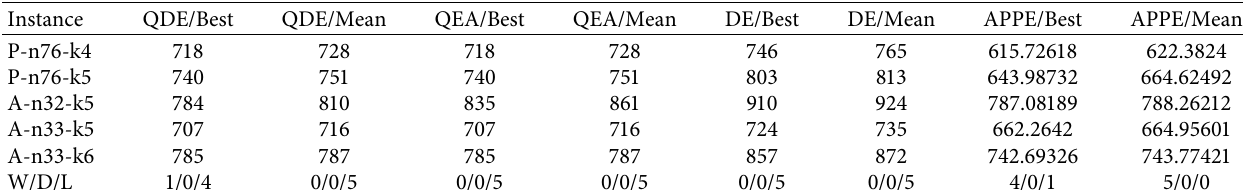
Table 18: Comparison of the best and mean results of 10 runs of APPE with the algorithms in Zhao et